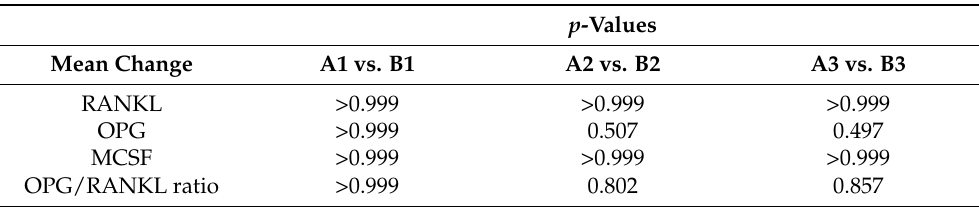
Table 3. Pairwise group per timing mean changes (final–initial) comparisons’ p ‐ values derived from linear regression models and adjusted for multiple comparison (Bonferroni).